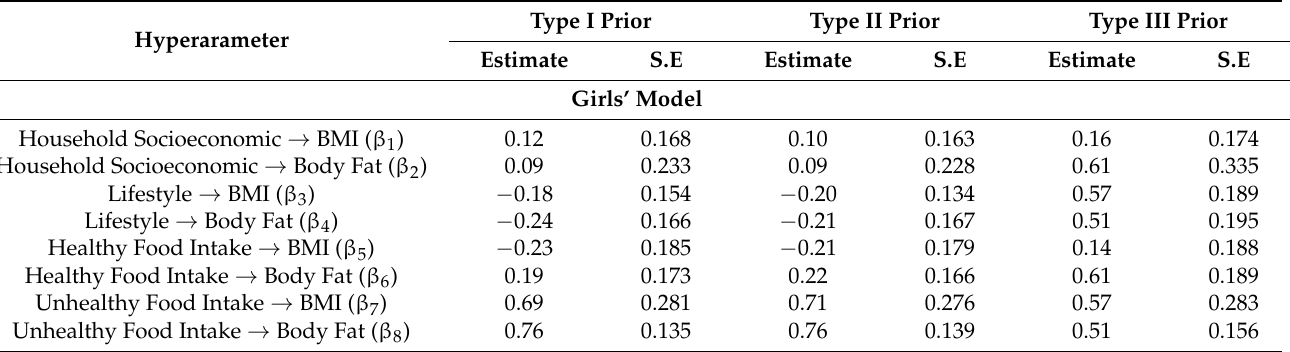
Table 5. Evaluated Bayesian estimators based on three different